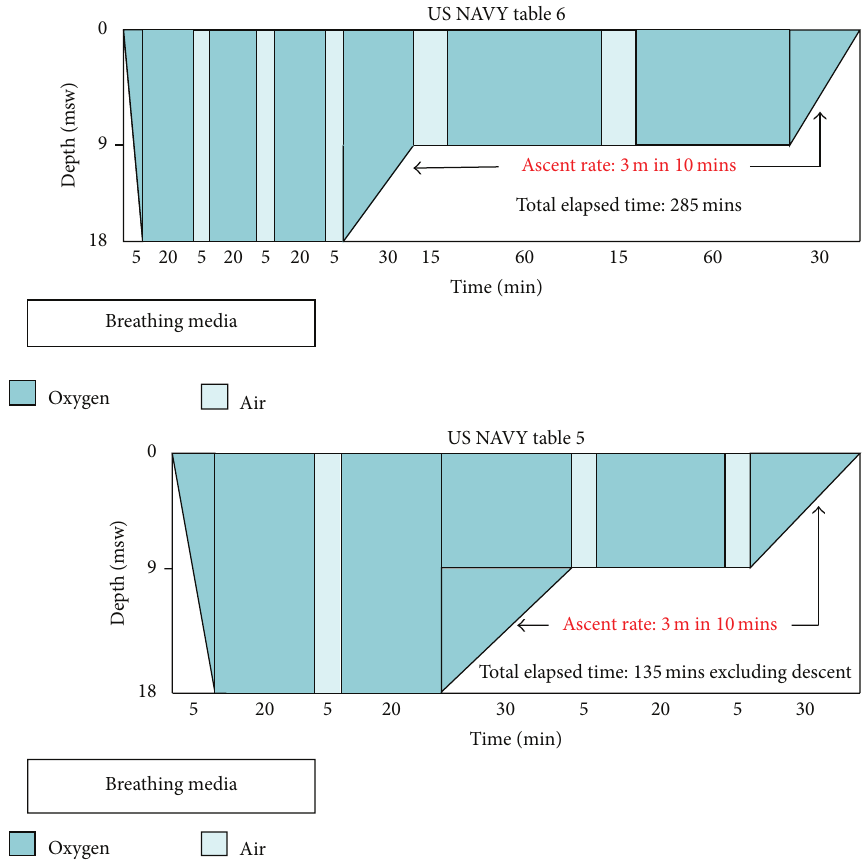
Figure 1: HBOT US NAVY table 6 and table 5. US NAVY table 6 consists of a compression phase about 5 minutes long to depth of 18msw under 100% oxygen and 4 oxygen cycles lasting 20 minutes each with short air intervals. Then, the patient is decompressed to about 9msw and exposed to 2 oxygen cycles lasting 60 minutes each and slowly returned to surface pressure. The total elapsed time is about 285 min (4hrs 45 min). US NAVY table 5 is similar to table 6 but with shorter and lesser oxygen cycles; the total elapsed time is about 135 min, excluding descent. Adapted from http://www.londondivingchamber.co.uk/.